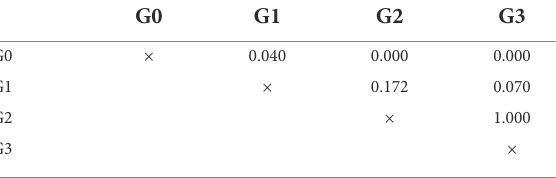
TABLE 10 One-way ANOVA test for different layouts (number of